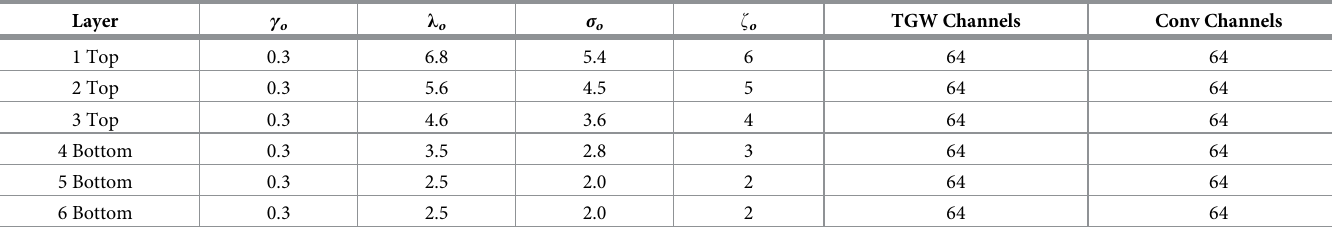
Table 1. Parameters used for the TGW